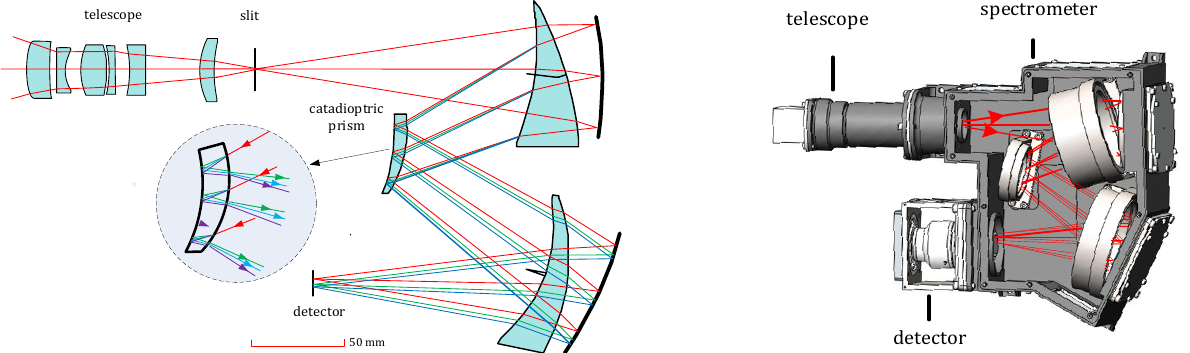
Figure 3. Optical layout and opto-mechanical layout of the system. In Figure 4, T and S represent the tangential and sagittal planes, respectively; the red curve represents the MTF of the maximum field of view (FOV); the green curve represents the MTF of the 0.5 FOV; the blue curve represents the MTF of the central FOV; and the MTF curves show that the average values are more than 0.5 for the full spectra.